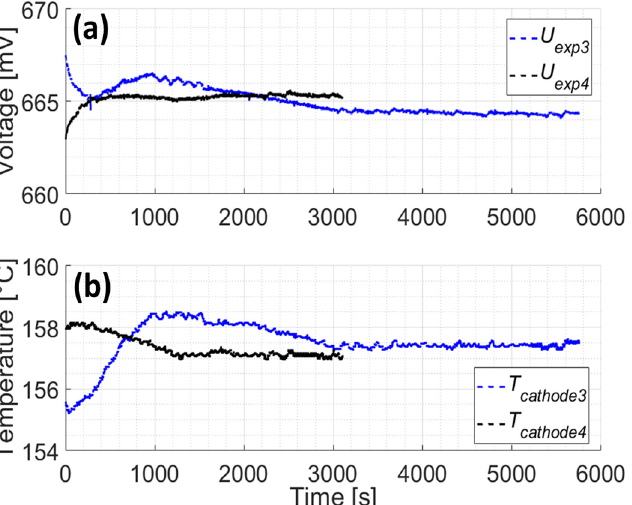
Figure 3. ( a ) Temporal evolution of voltages ( U exp3 , U exp4 ); ( b ) Corresponding cathode temperatures. Recorded at 0.2 A/cm² after two different ramps (not represented) using an Advent PBI MEA (45.2 Recorded at 0.2 A/cm 2 after two different ramps (not represented) using an Advent PBI MEA cm²), without back-pressure regulation and with stoichiometries of 1.2/2 for H 2 /air. (45.2 cm 2 ), without back-pressure regulation and with stoichiometries of 1.2/2 for H 2